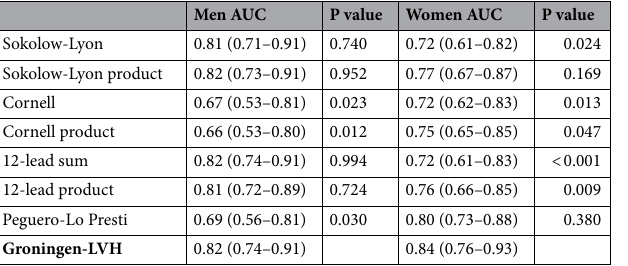
Table 6. Area under the curve of the new developed criteria versus AUCs of existing criteria in the validation cohort. AUC area under the curve, LVH left ventricular